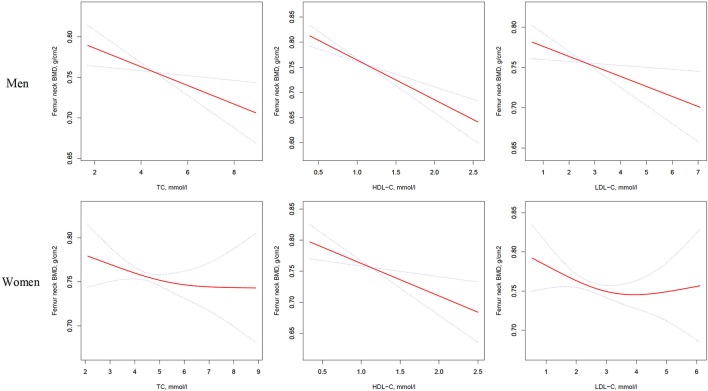
Multivariate adjusted smoothing spline plots of femur neck BMD by TC, HDL-C, and LDL-C. Red dotted lines represent the spline plots of TC, HDL-C, and LDL-C and blue dotted lines represent the 95% CIs of the spline plots. Adjusted for age; diabetic duration(y); treatment of DM; smoking; drinking; BMI; cerebrovascular disease; kidney disease; family history of DM; diastolic blood pressure; FBG, unit; Cr, umol/l; BUN, mmol/l; Ca, unit; ALT, U/L; AST, U/L; ALP, U/L.